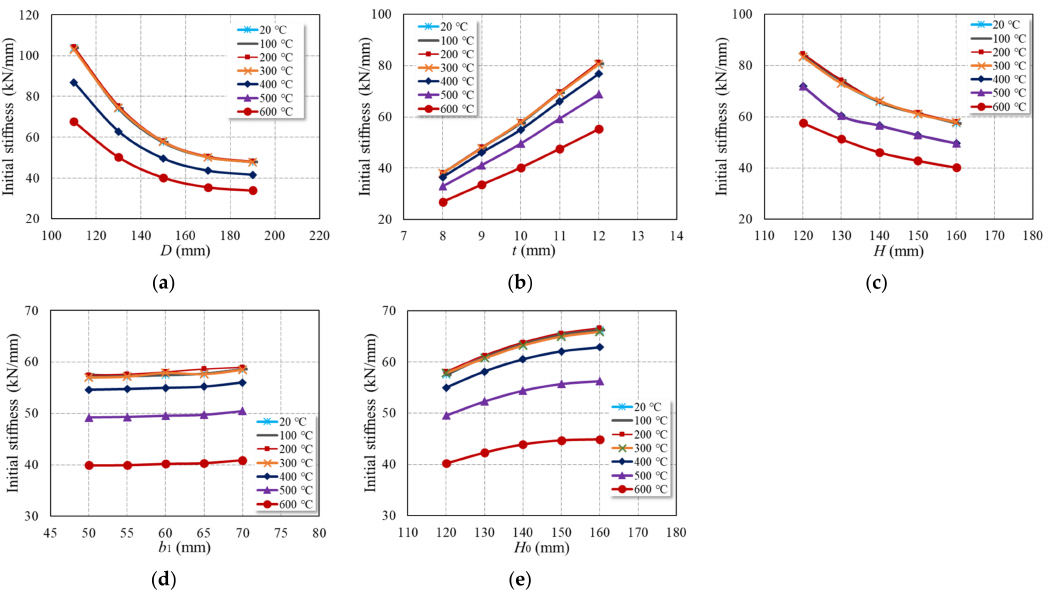
Figure 12. Effects of parameters on the initial stiffness of BBC joints under tension: ( a ) outer diameter of the tube; ( b ) thickness of the tube; ( c ) height of the tube; ( d ) width of the tubular beam; ( e ) height of the tubular